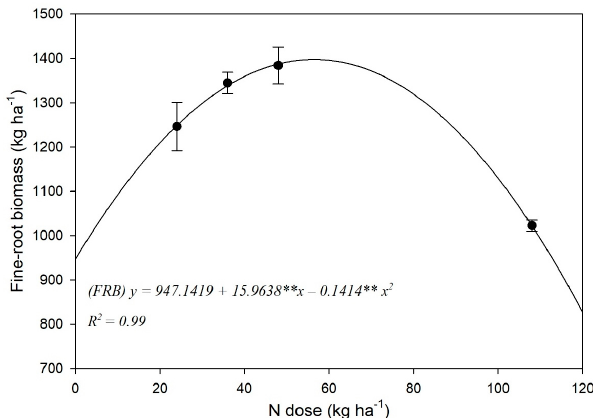
Figure 3. Fine-root biomass ( FRB ) until 40 cm depth at 2.95-year-old E. dunnii Maiden plantation as affected by N fertilization. Vertical bars represent standard errors ( n = 4). ** indicates parameter is significant at 5%.